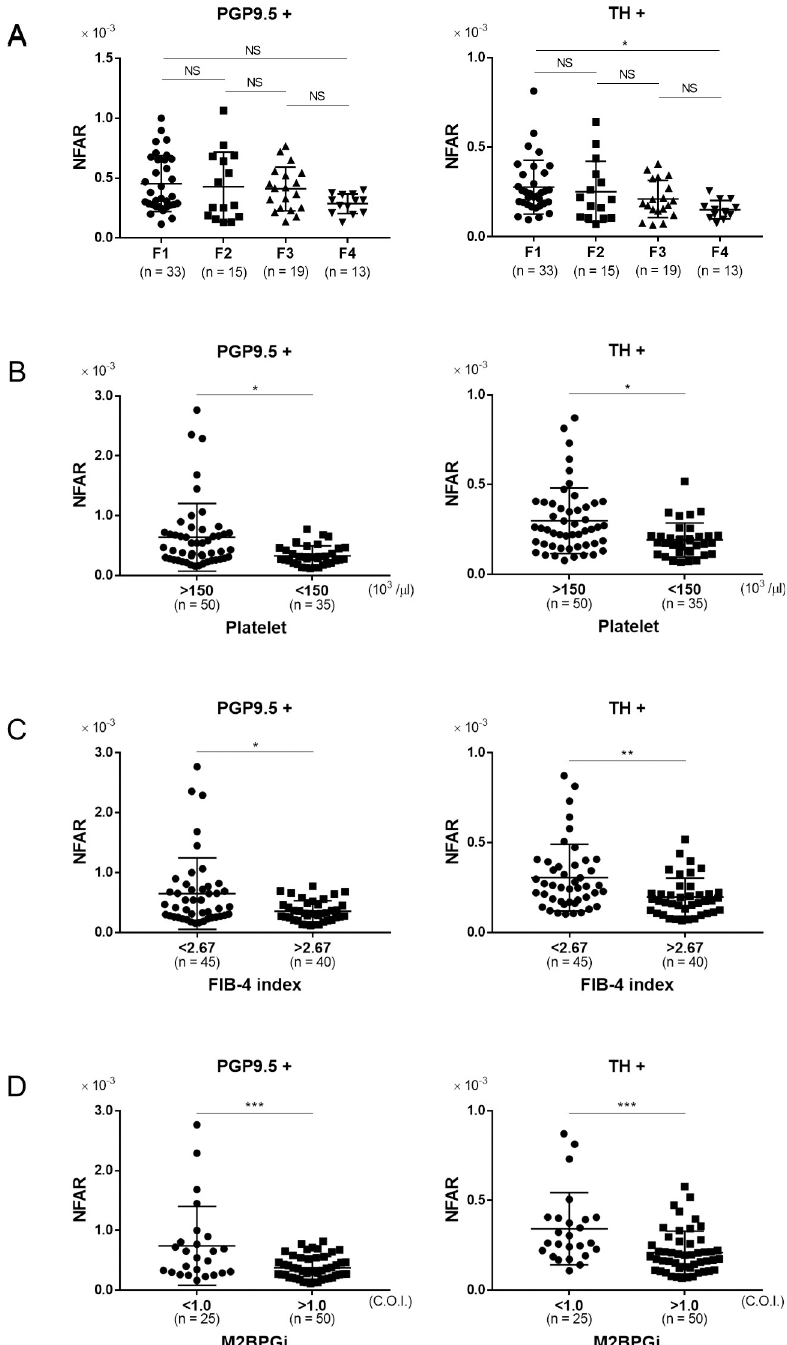
Fig 3. The relationship between fibrosis and NFAR. Comparison of NFAR for whole nerve fibers (PGP9.5+) and sympathetic nerve fibers (TH+). A: mild fibrosis (F1) to cirrhosis (F4), B: higher platelet count ( � 150 × 10 3 / μ l) vs. lower platelet count ( < 150 × 10 3 / μ l), C: lower FIB-4 index ( < 2.67) vs. higher FIB-4 index ( � 2.67), D: lower Mac-2 binding protein glycosylation isomer (M2BPGi) level ( < 1.5 C.O.I.) vs. higher M2BPGi level ( � 1.5 C.O.I.). Data were analyzed by unpaired t test. � P < 0.05, �� P < 0.01, ��� P < 0.001.